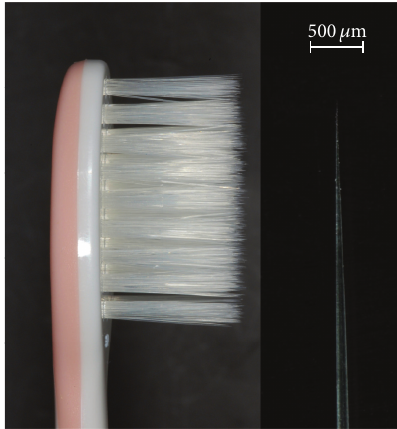
Figure 1: The head of the test toothbrush (TB1) and an extra-fine conical bristle.